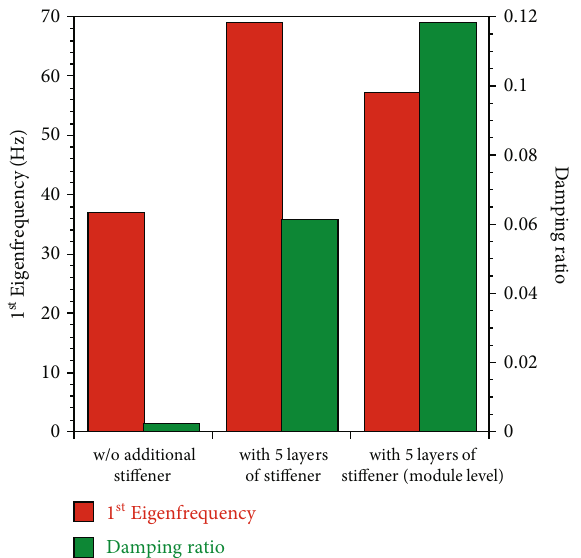
Figure 6: Basic dynamic characteristics of the solar panels according to clamping boundary